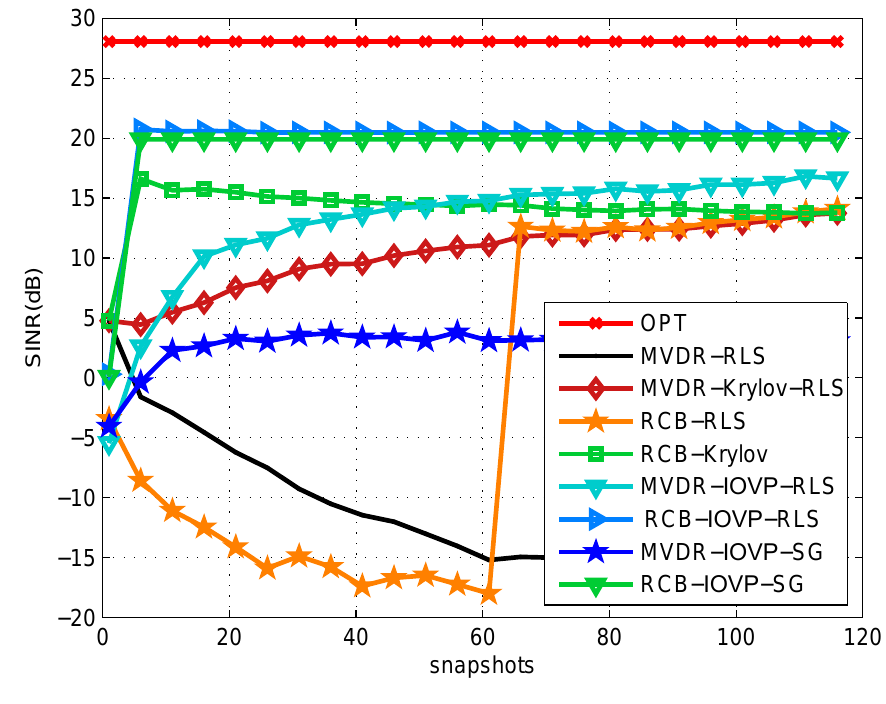
Figure 2. Signal-to-interference plus noise ratio (SINR) performance vs . the number of snapshots, with steering vector mismatch due to 2°DoA mismatch. The spherical uncertainty set is assumed for robust beamformers (cid:15) = 140 (RLS − 1 indicates that the value ˆ R is obtained by using RLS adaptation), non-orthogonal [ i ] S C 64 × 2 projection D ∈